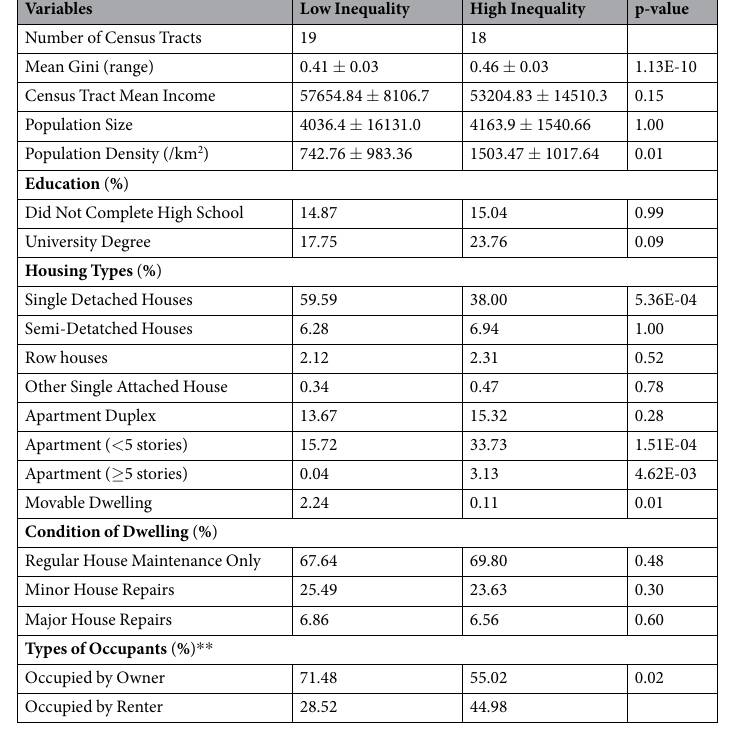
Table 1. Low Vs High Inequality Census Tract Demographics and Housing * . * All data was obtained from the 2006 Canadian Census. P-values were generated using non-parametric Man-Whitney test unless otherwise specified. ** p-value generated by chi-squared